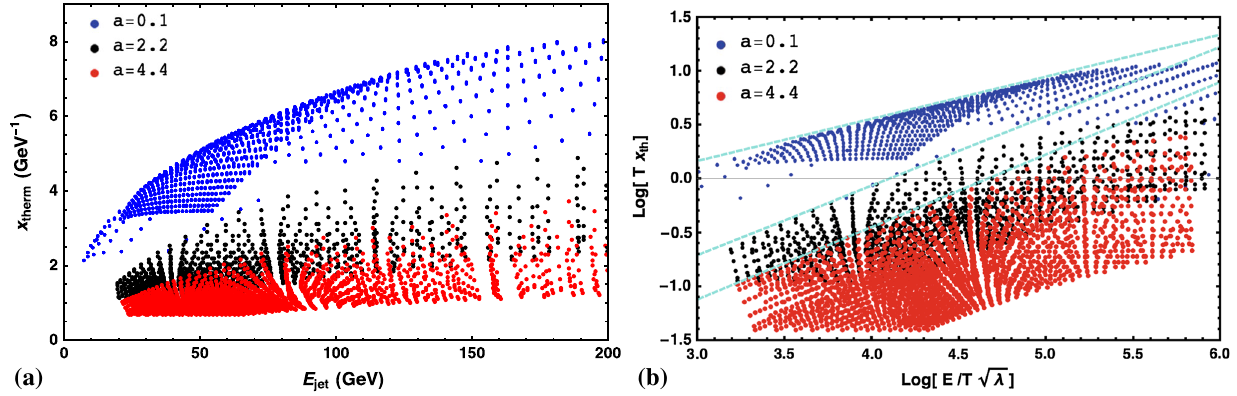
Fig. 4 a The stopping distance of the jet moving in the anisotropic backgrounds with different anisotropy parameters in terms of its energy and b the log–log plot of the quark stopping distance as a function of total quark energy E for many falling strings with different initial con-